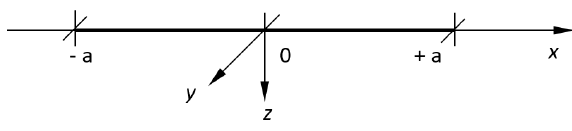
Figure 1: Static scheme of considered system.